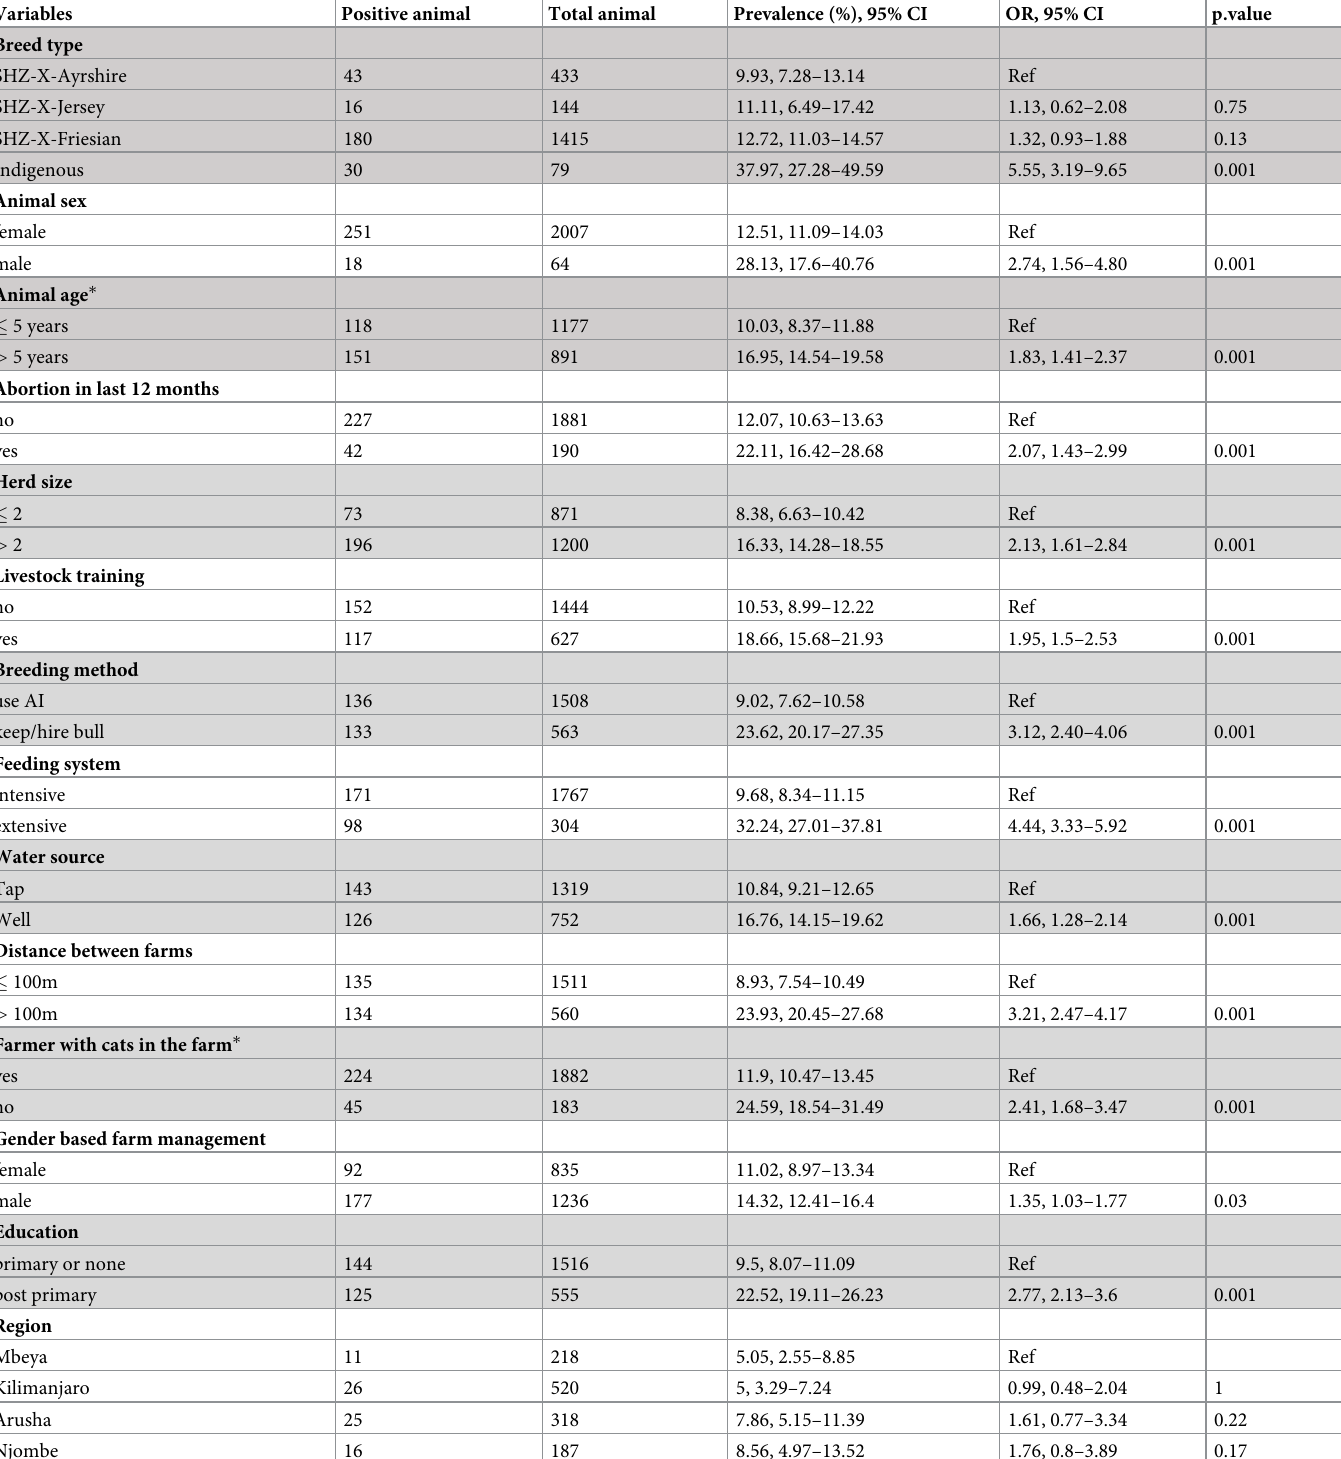
Table 1. Univariable associations between Leptospira serovar Hardjo seropositive results in dairy cattle and a set of variables. Independence test (fisher exact) two- sided p-values (P-value) is provided for each